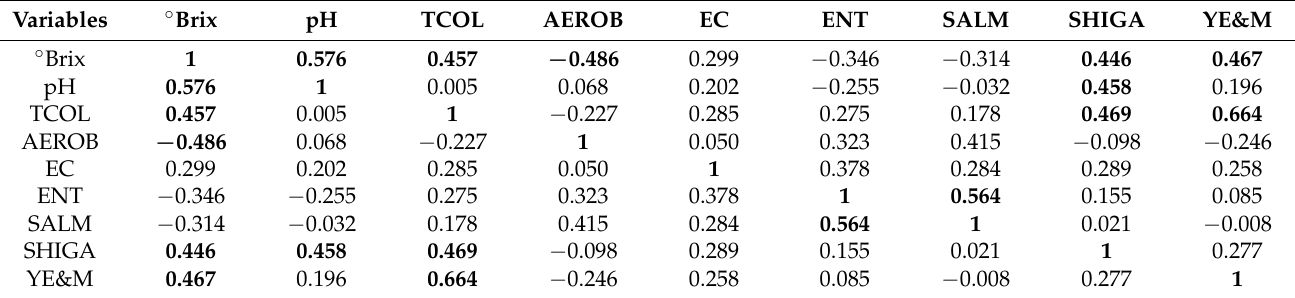
Table 3. Pearson correlation coefficient of 9